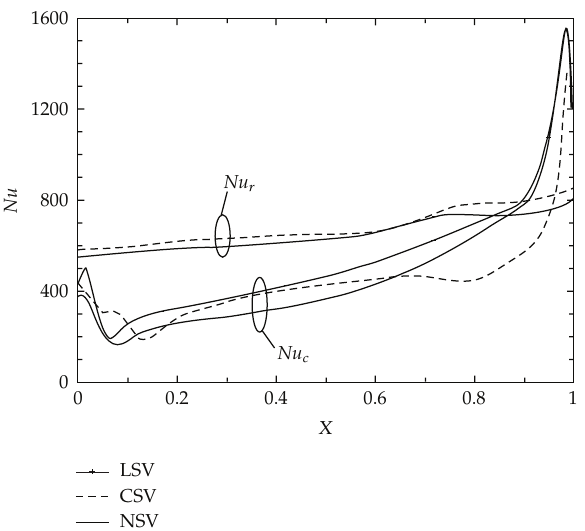
Figure 7: Nu c and Nu r distributions along the floor for the cases shown in Figure 2.